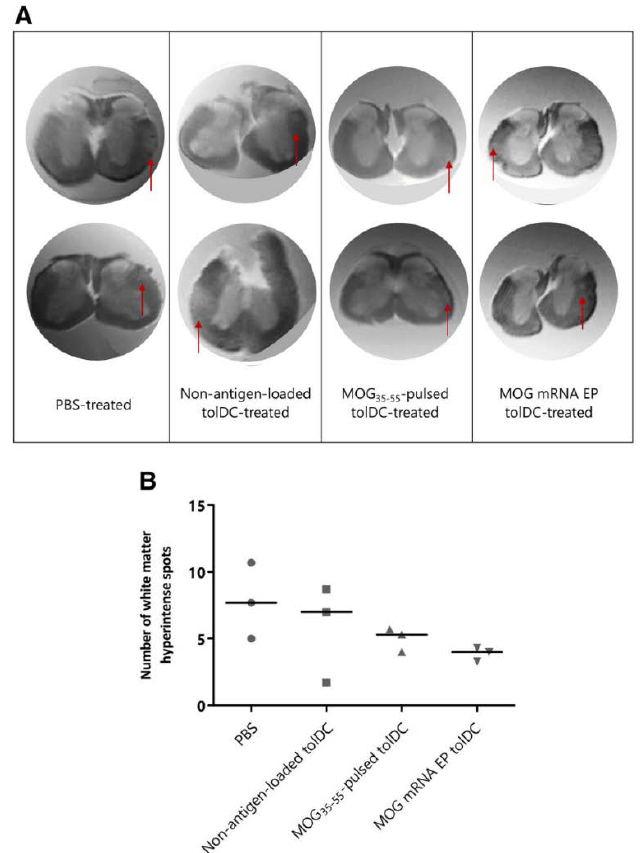
Figure 9. Evaluation of inflammatory lesion load within the spinal cord of tolDC-treated and PBS-treated mice using ex vivo MRI imaging. ( A ) Representative MRI of spinal cord with hyperintense white matter spots marked with a red arrow. Two representative axial slices are shown per treatment group. ( B ) The total number of hyperintense white matter spots along the entire spinal cord was quantified as a measure of lesion load in three mice per treatment group. Results are presented as individual scores for hyperintense spots with median [154].